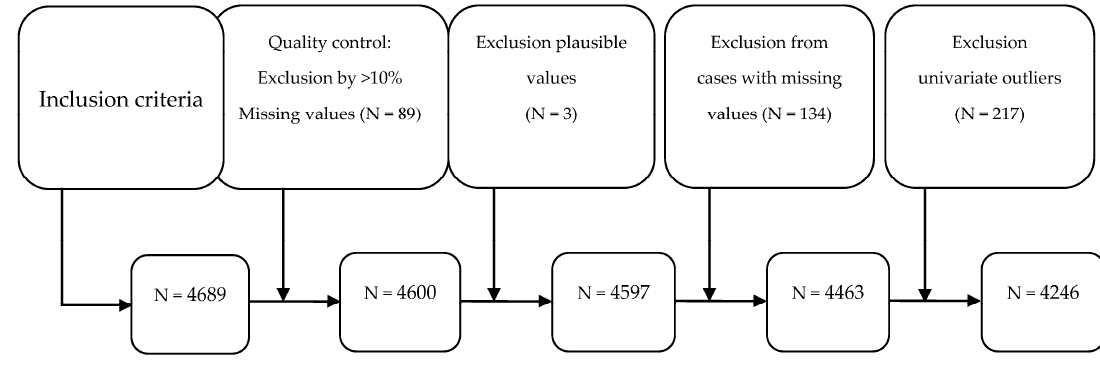
Figure 2. Sample flow during the exclusion process.